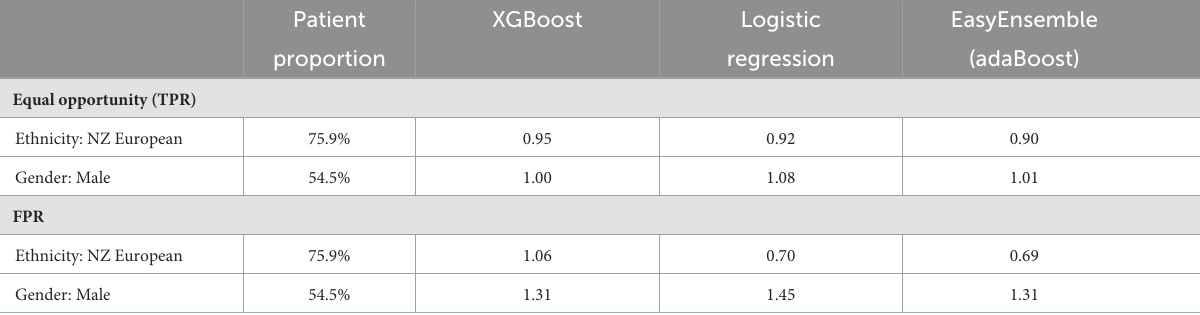
rejected. The null hypothesis was that gender or ethnicity related tokens and the harm labels are